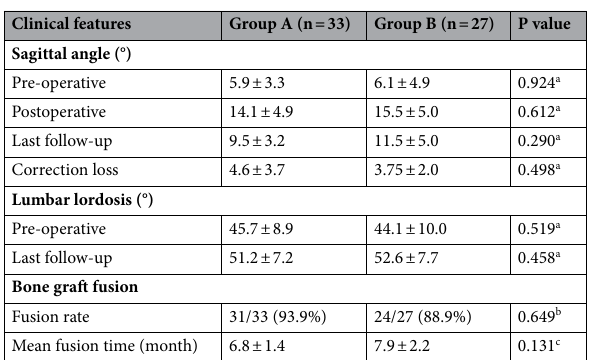
Table 2. Comparison of Radiological changes between the two groups. a Data was analyzed using Student t test. b Data was analyzed using Fisher’s exact test. c Data was analyzed using Mann–Whitney U test.